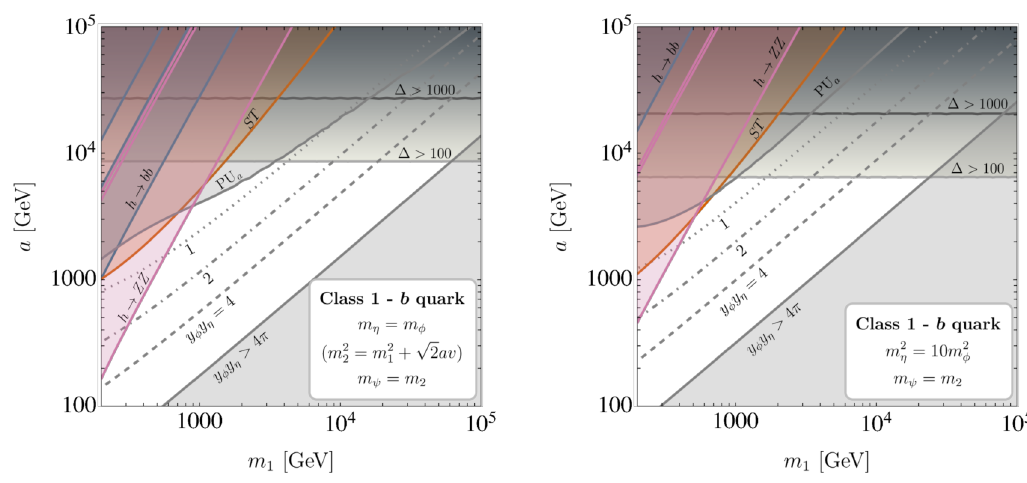
Figure 5. Theoretical (grey) and current 2 σ experimental constraints (coloured) on the Class 1 b -quark benchmark